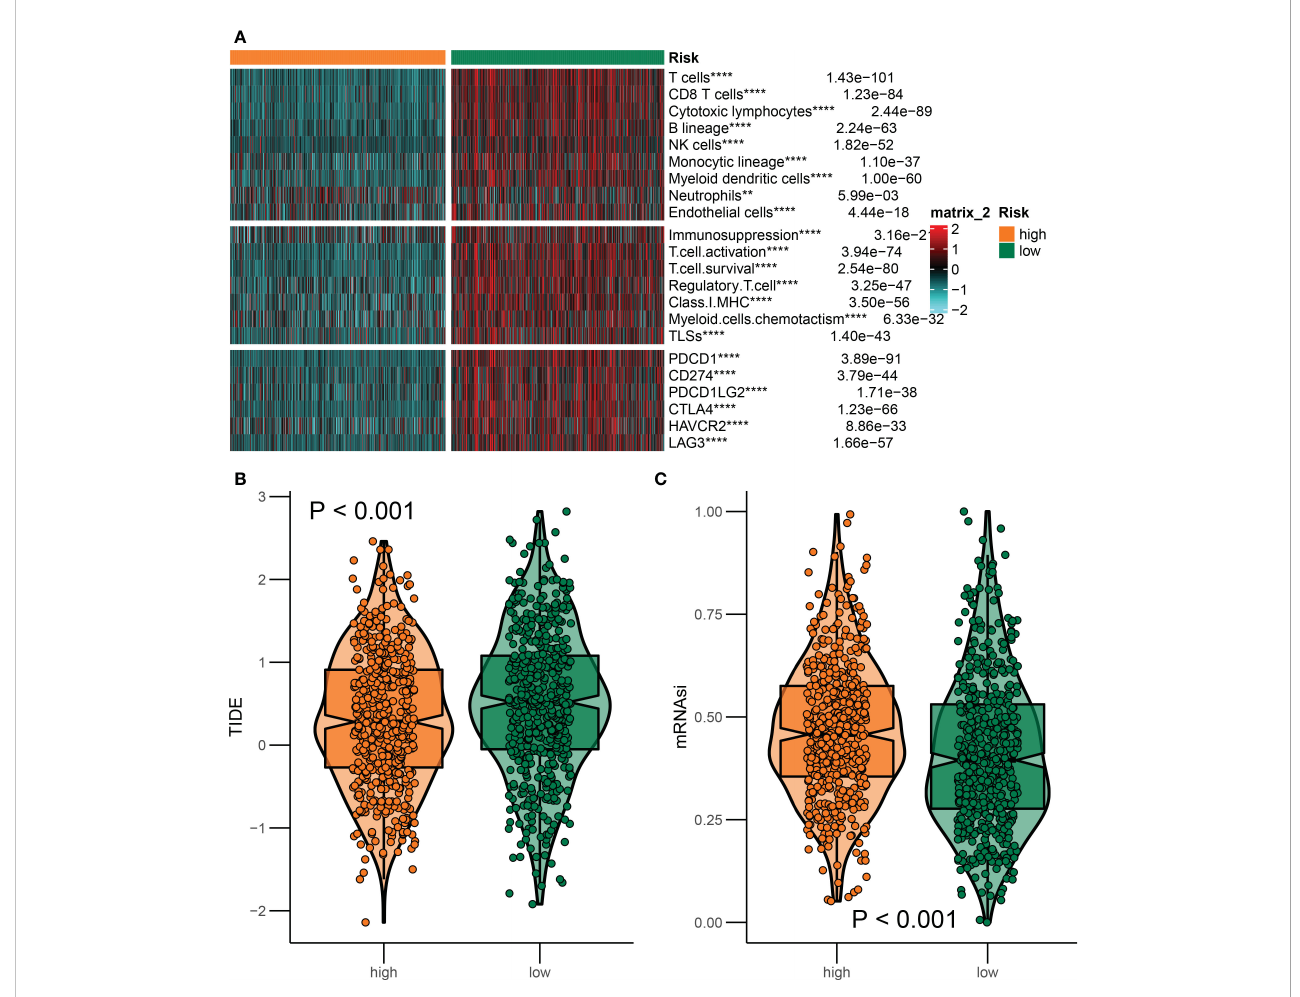
FIGURE 8 Differences in the immune landscape between the two groups. (A) Heatmap of immune characteristics in the high-risk and low-risk groups. (B, C) The association of ICDRGs risk score with immunotherapy response. **P<0.01; ***P<0.005;